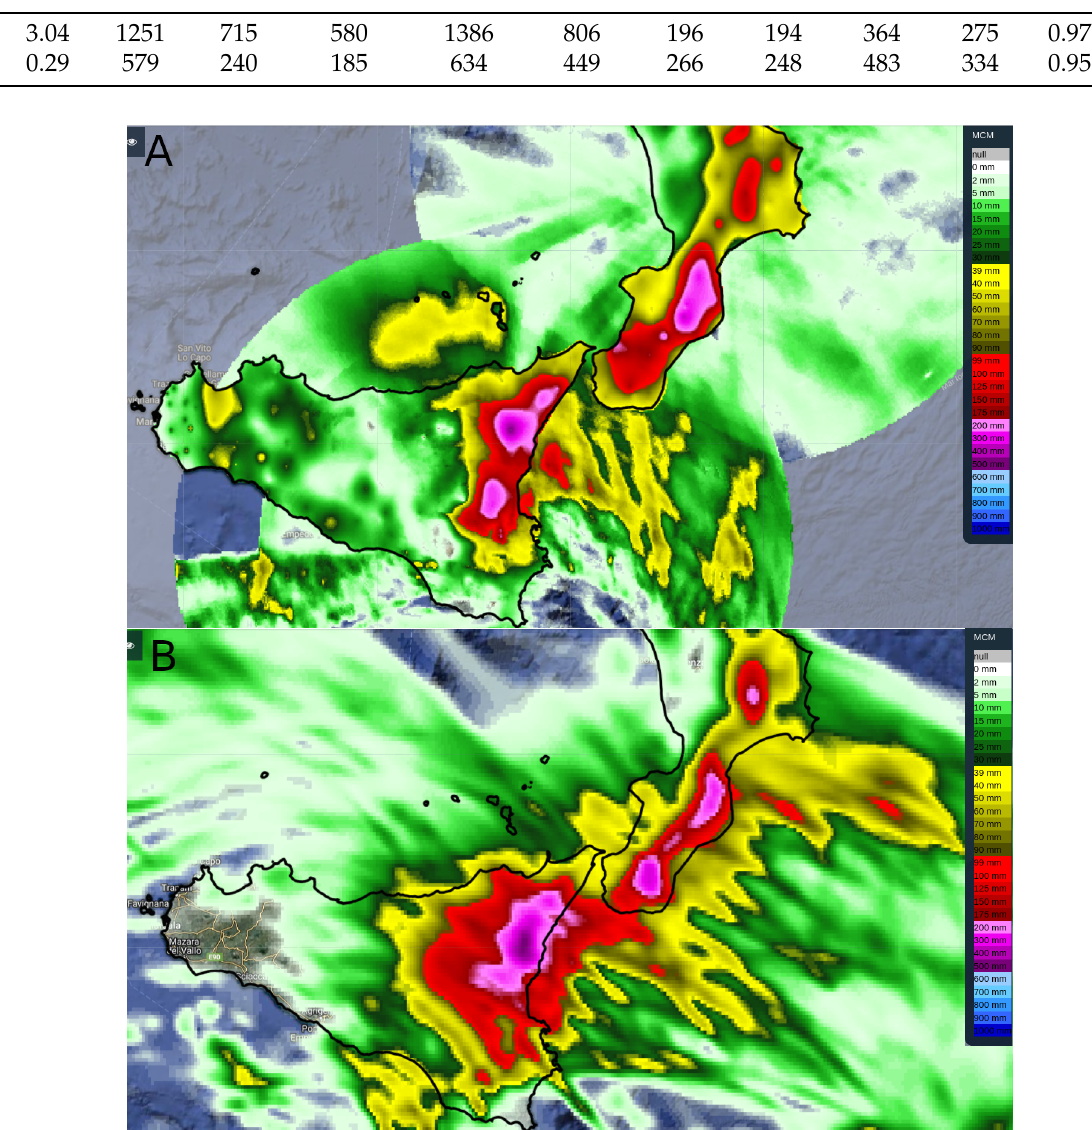
Figure 14. Observed (Panel ( A )) and modeled (WRF-DA, Panel ( B )) 48 h cumulated rainfall between 24–26 October